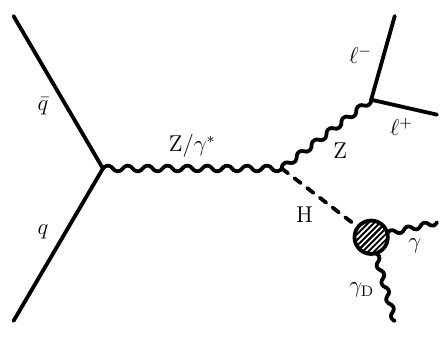
Figure 1 . A Feynman diagram for the production of the Z( ! ‘‘ )H( ! (cid:13)(cid:13)